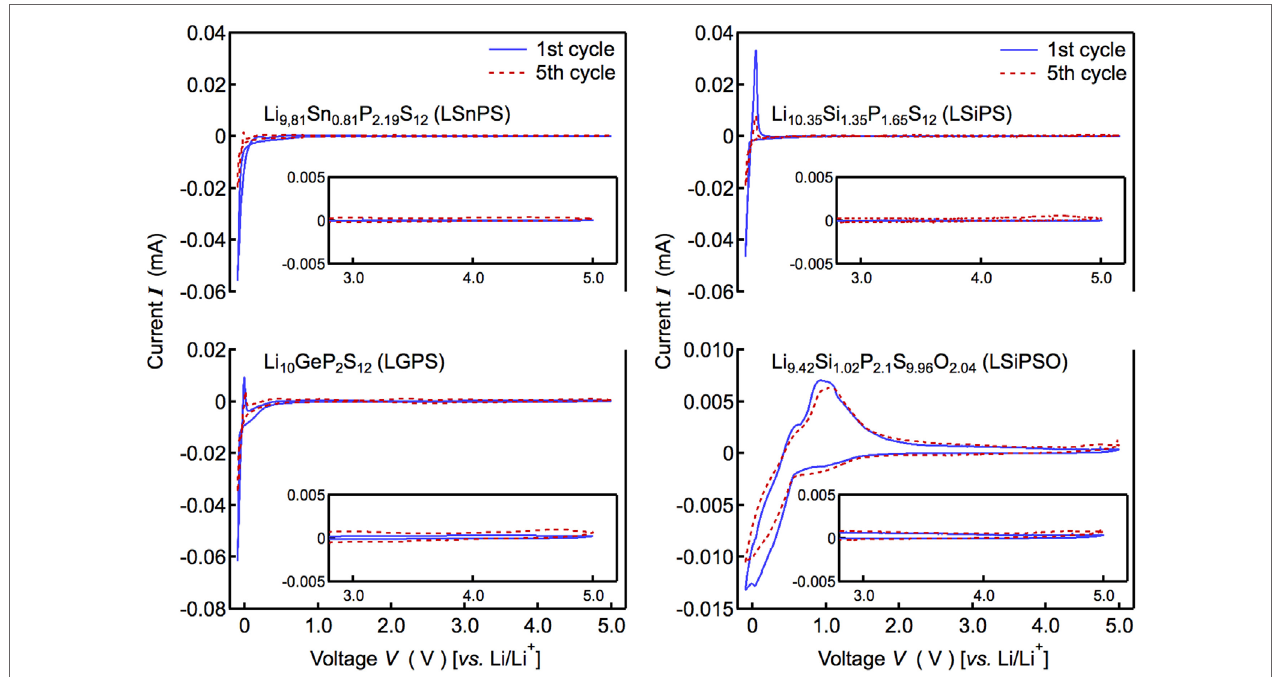
FigUre 5 | current–voltage curves of the li/li 9.42 si 1.02 P 2.1 s 9.96 O 2.04 /stainless steel cell . The figure also shows the data corresponding to the Si-, Sn-, and Ge-based LGPS-type solid